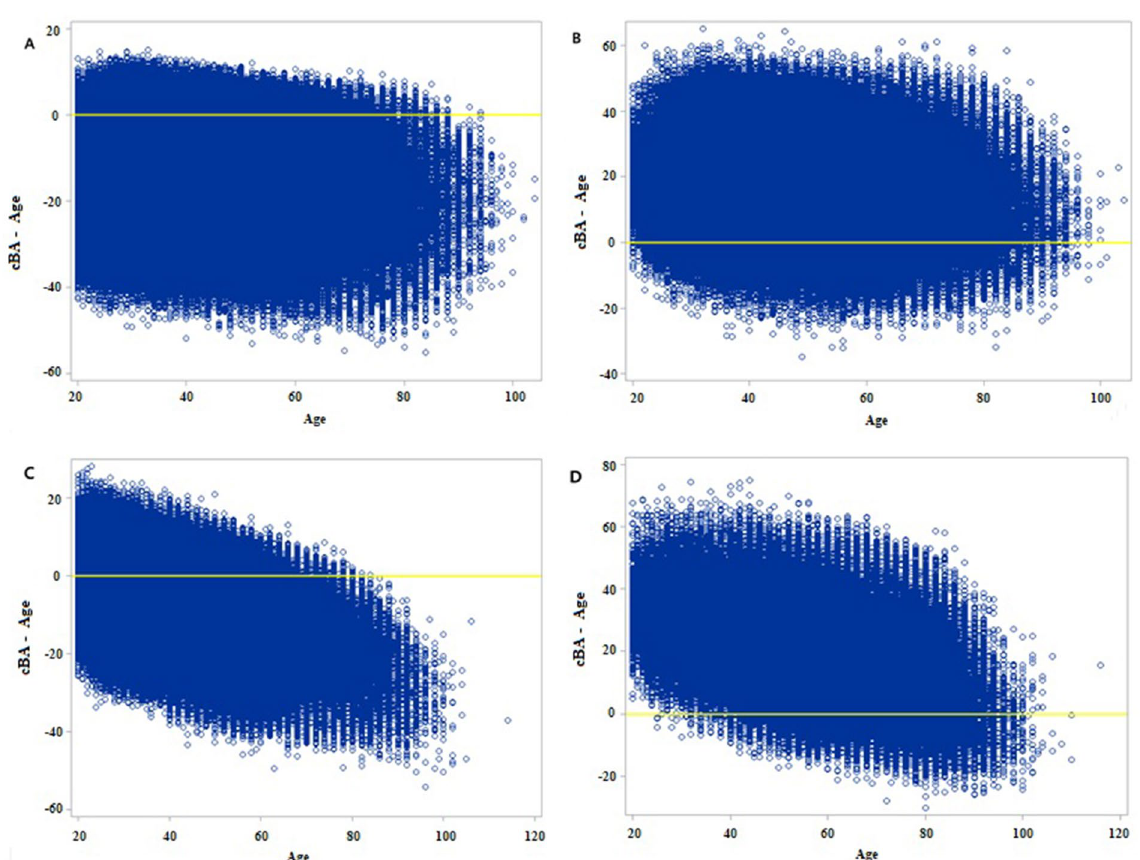
Figure 2. The scatter plot of discrepancy between conventional diagnosis. Y axis means the difference of MS BA and chronological age. X axis was chronological age. ( A ) normal male group, ( B ) MS male group, ( C ) normal female group, ( D ) MS female